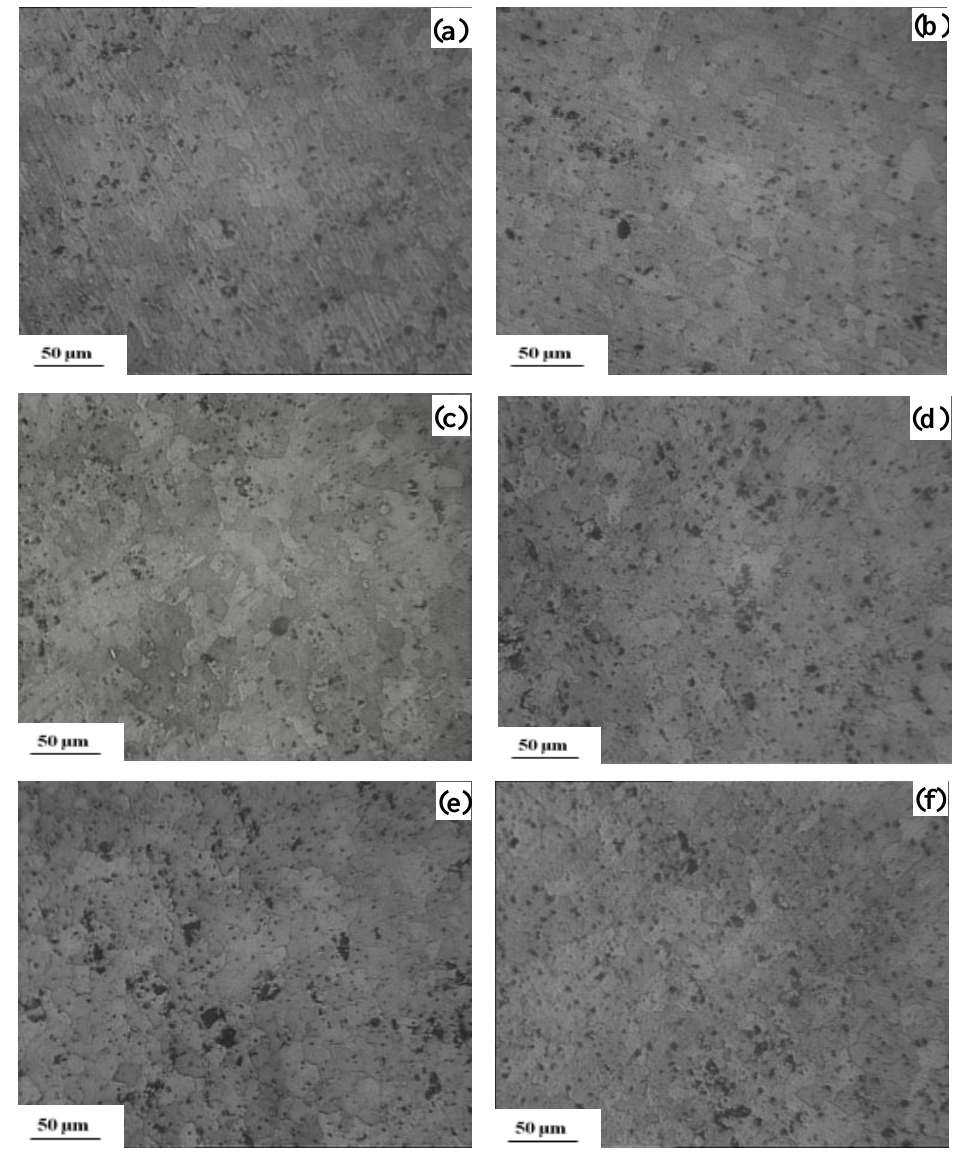
Fig. 4. Optical micrographs of 2017A-T4 alloy aged at 170 °C for different